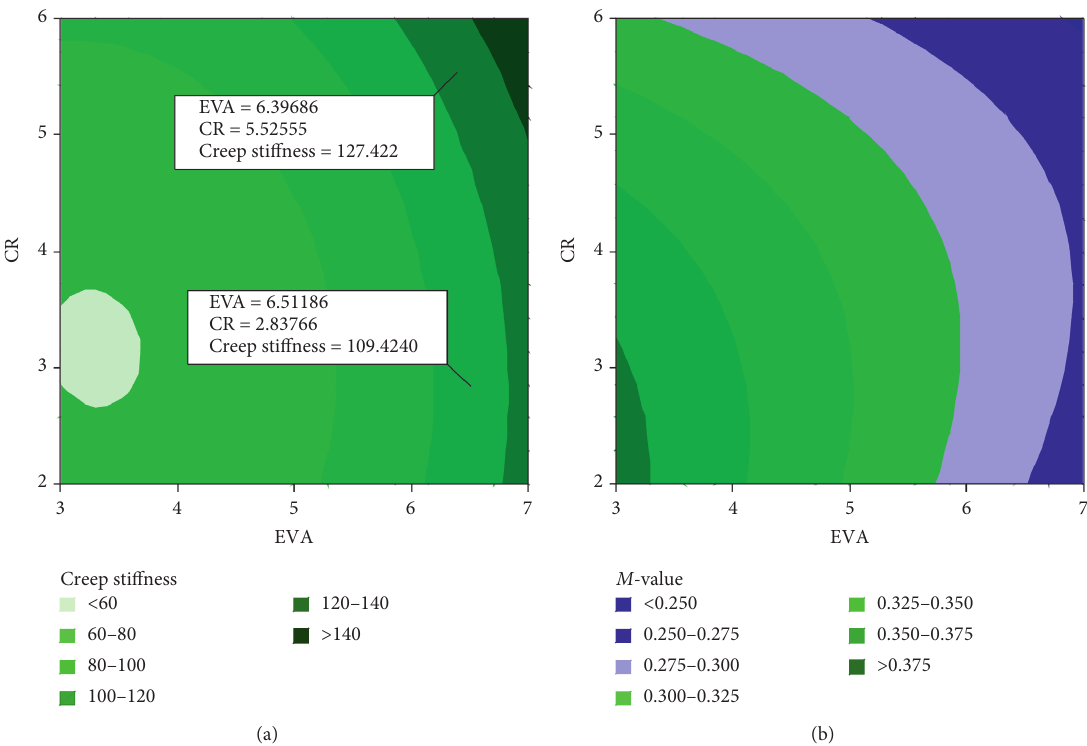
Figure 3: Contour plot of BBR tests. (a) Contour plot of creep stiffness vs. CR and EVA. (b) Contour plot of m -value vs. CR and